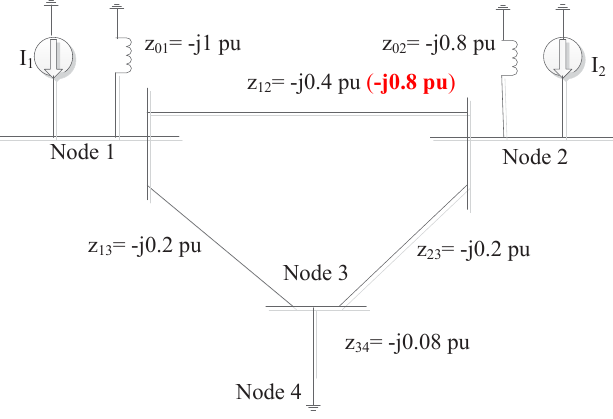
Figure 2. Three bus test system